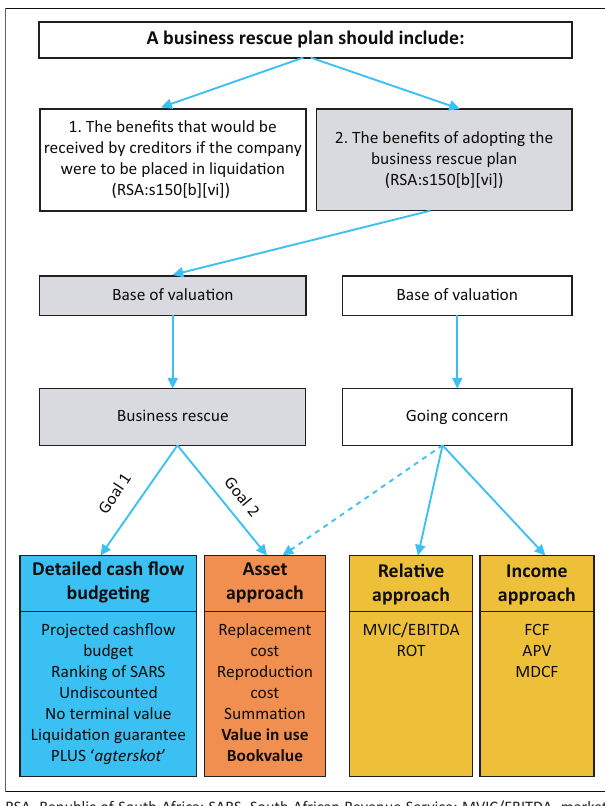
FIGURE 4: Valuation approaches used in business